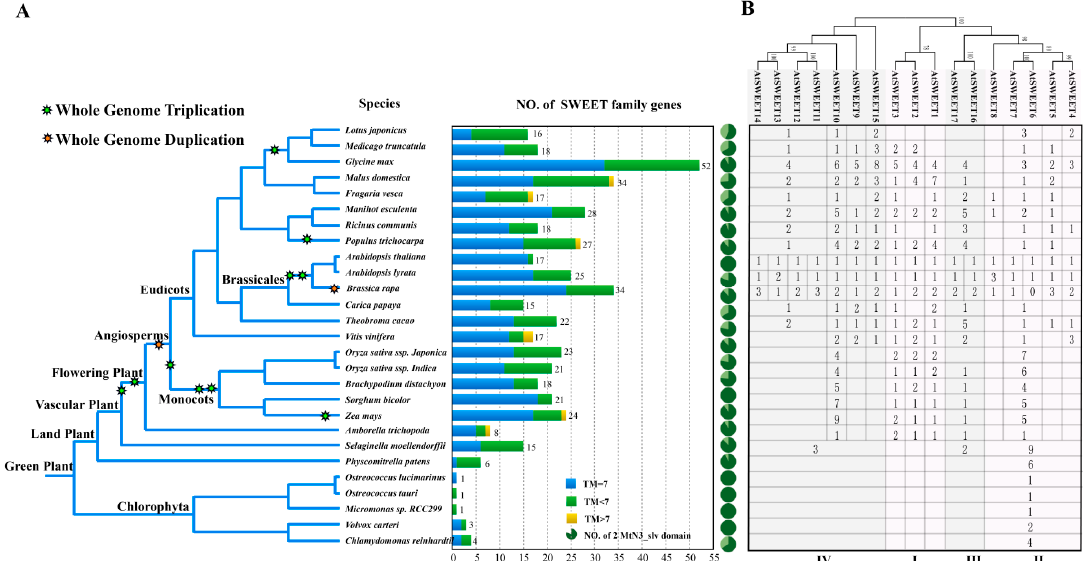
Figure 1. Molecular footprint and phylogenetical classification of SWEETs in the plant kingdom. ( A ) Identification and distribution of homologous SWEETs in different plants and ( B ) functional classification based on maximum likelihood (ML) phylogenetic analysis by Figure S1.